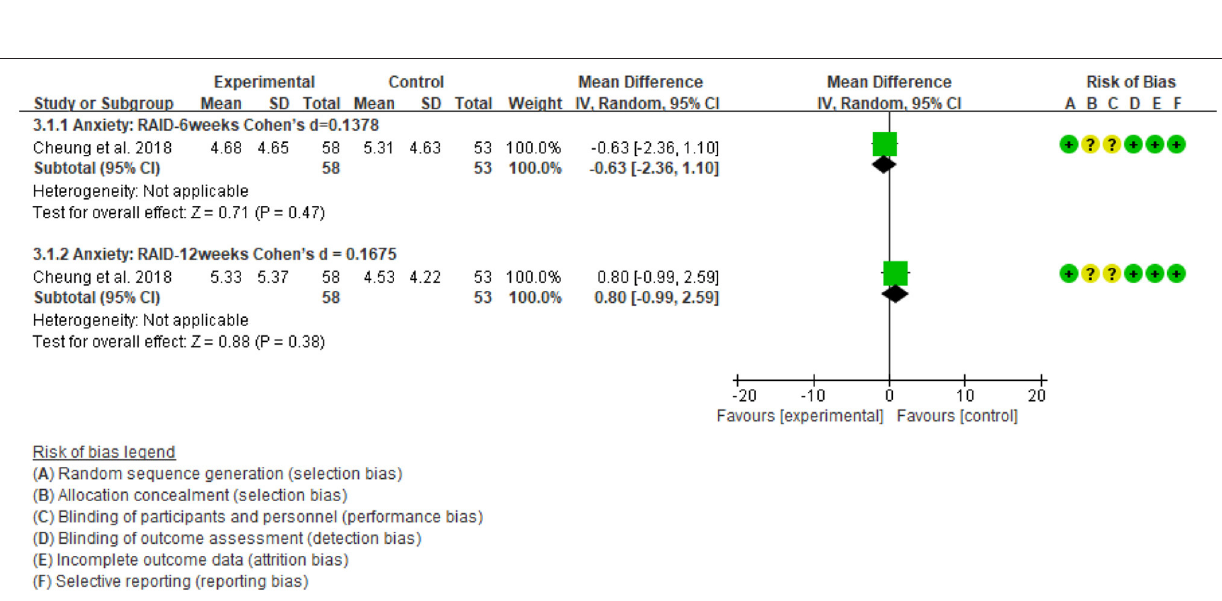
FIGURE 9 | Subgroup analyses of the intervention group vs. the control group on depression rating scores: Intervention countries.